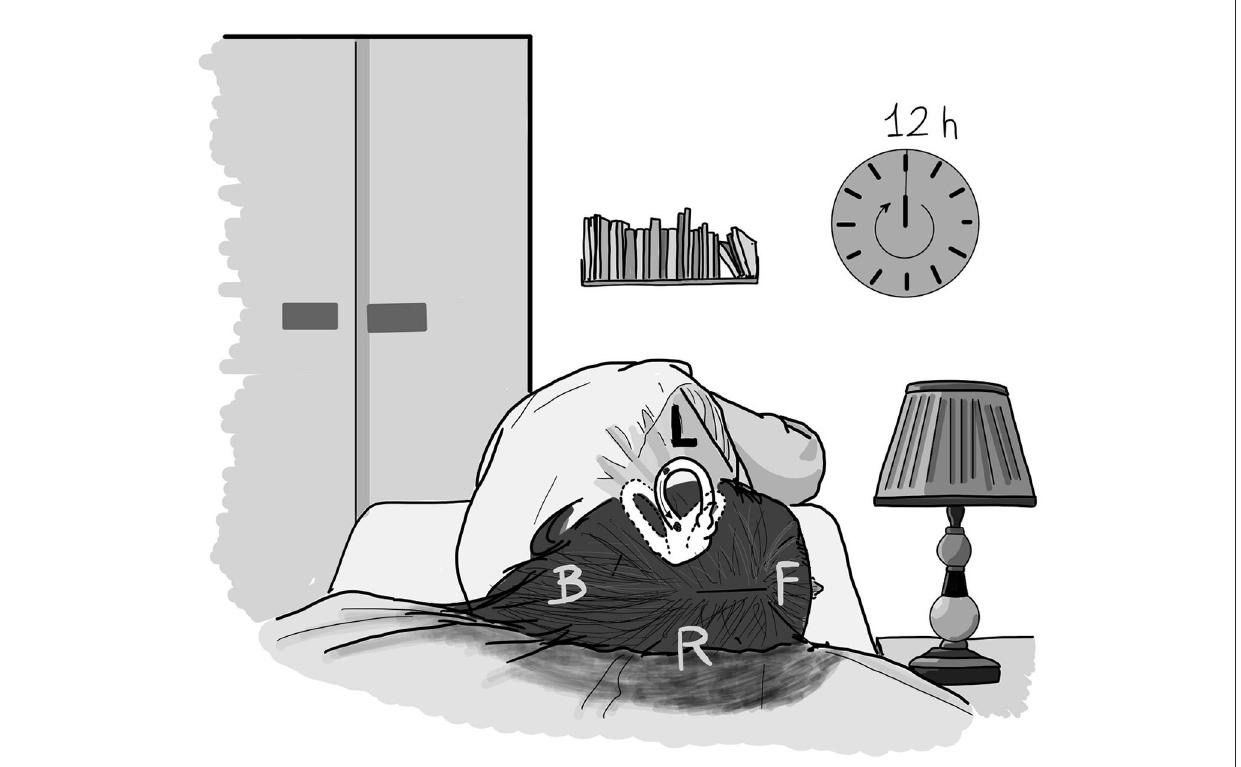
FIGURE1 The forced prolonged position (FPP) in case of a left geotropic LSC BPPV. The patient lay for 12h in the right-side lateral position when supine. The debris, initially located in the posterior arm of the left LSC, gradually shifted toward the vestibule under the effect of gravity. F, front; B, back; L, left; R,